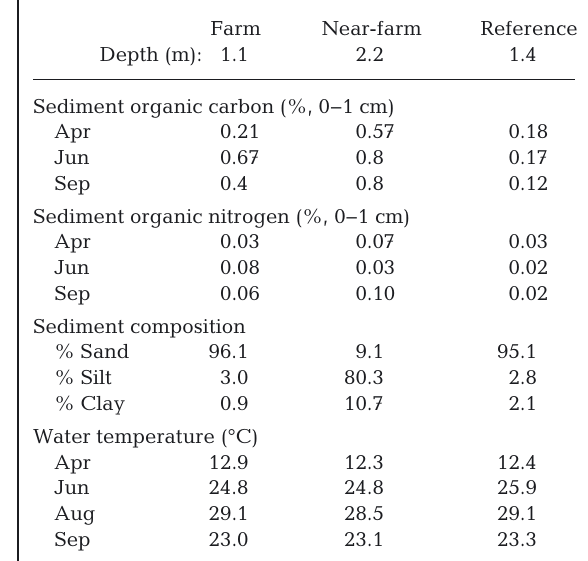
Table 1. Characteristics of the farm (n = 4), near-farm (n = 2), and reference (n = 1) sampling sites. Sediment (0–1 cm depth) composition values correspond to medians for sampling sites measured in April 2011, where the overall median for the study area is 90.4% sand, 5.9% silt, and 3.7% clay (n =